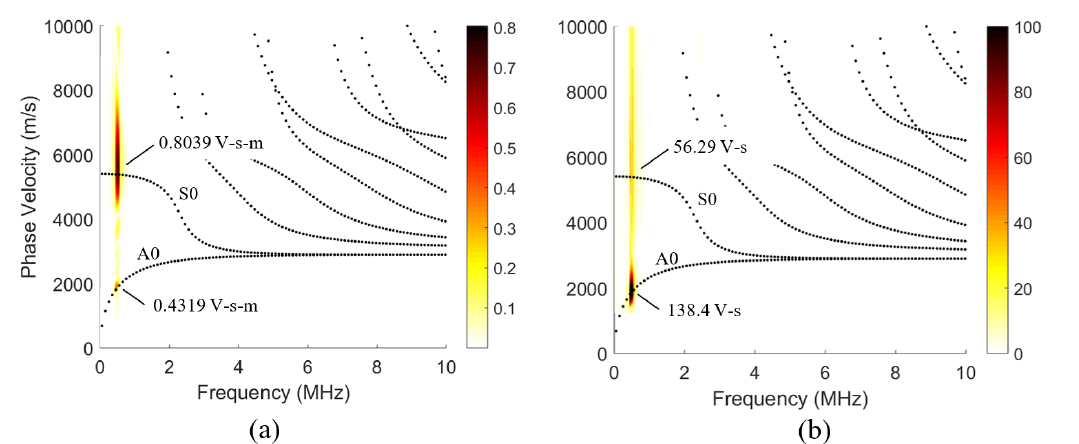
Figure 8. Phase velocity-frequency spectrum from: ( a ) the PVDF transducer; and ( b ) the air-coupled transducer when used to receive a 0.5 MHz pulse from a Plexiglas-wedge transducer with a 30 ◦ angle of incidence. Color axis restricted for easier viewing of features. Numerically calculated Lamb wave dispersion curves (black dots) added for reference.